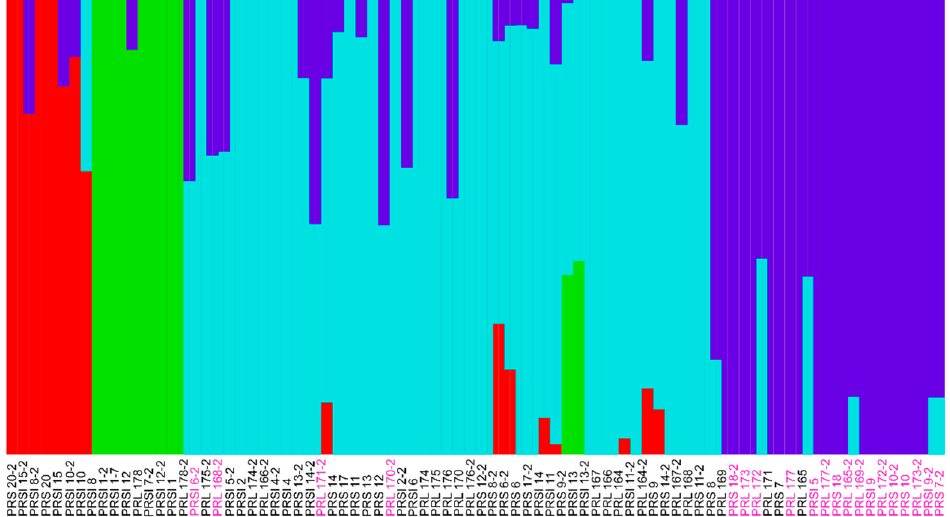
Figure 5. Genetic structure inferred by FastStructure on 82 haplotypes representing 41 samples at k = 4. Samples in pink text contain the SfABCC2mut allele.